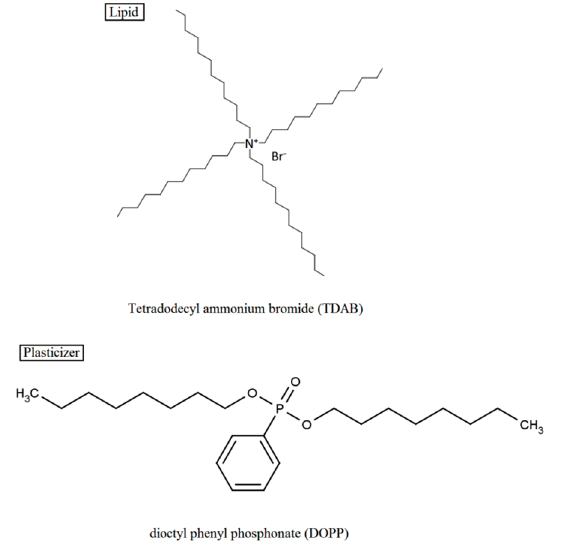
Figure 2. Structure of the lipid and plasticizer used for the lipid-polymer